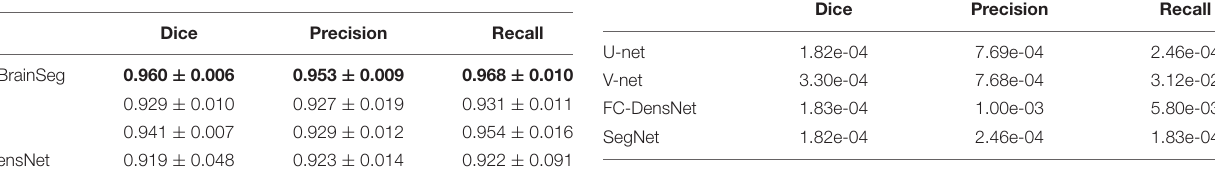
TABLE 3 | Quantitative comparison among DeepBrainSeg and other methods (bold values are the highest).